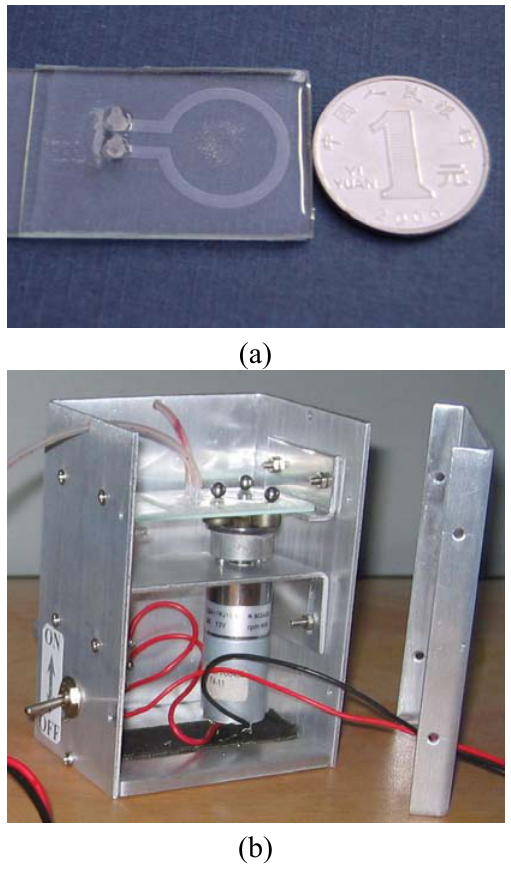
Figure 3. Pictures of a produced micro pump (a) view of a pump chip; and (b) a simple driving setup with a pump